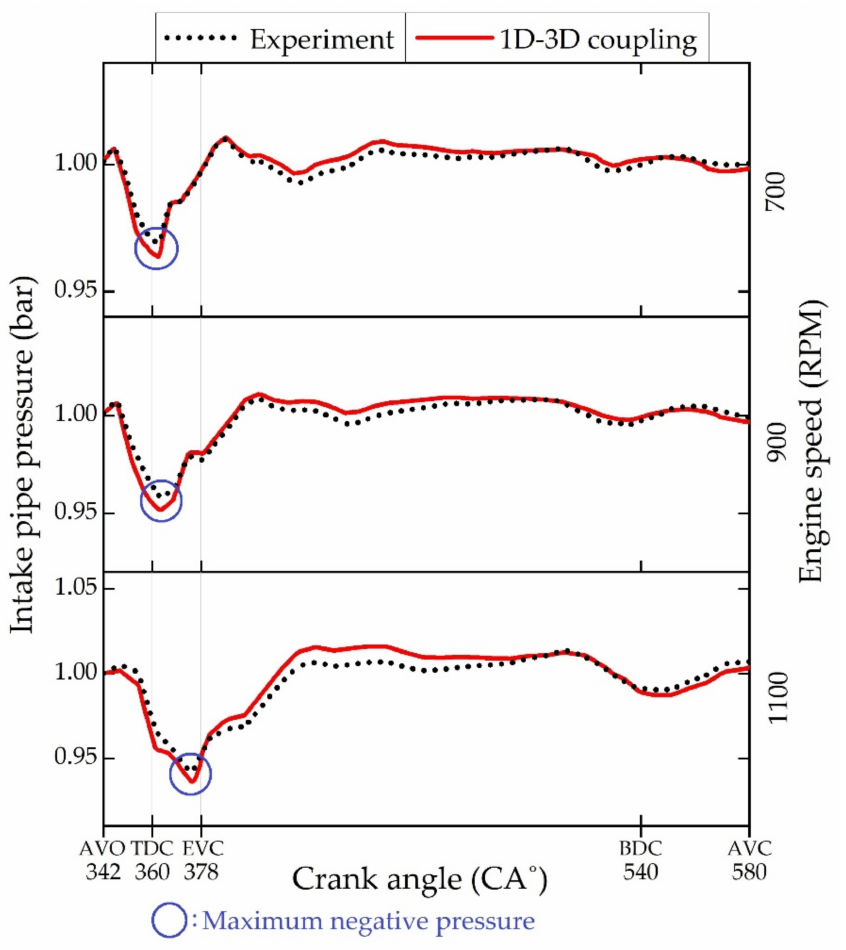
Figure 8. Intake pipe pressure results of the 1D–3D coupling gas flow analysis and experiment when the air-intake valve was open.